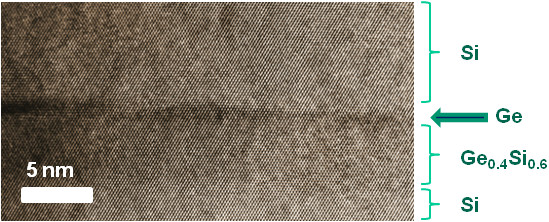
High-resolution TEM image of Ge quantum dots (dGe= 0.3 nm) on 5-nm-thick Ge0.4Si0.6 at 500°C.